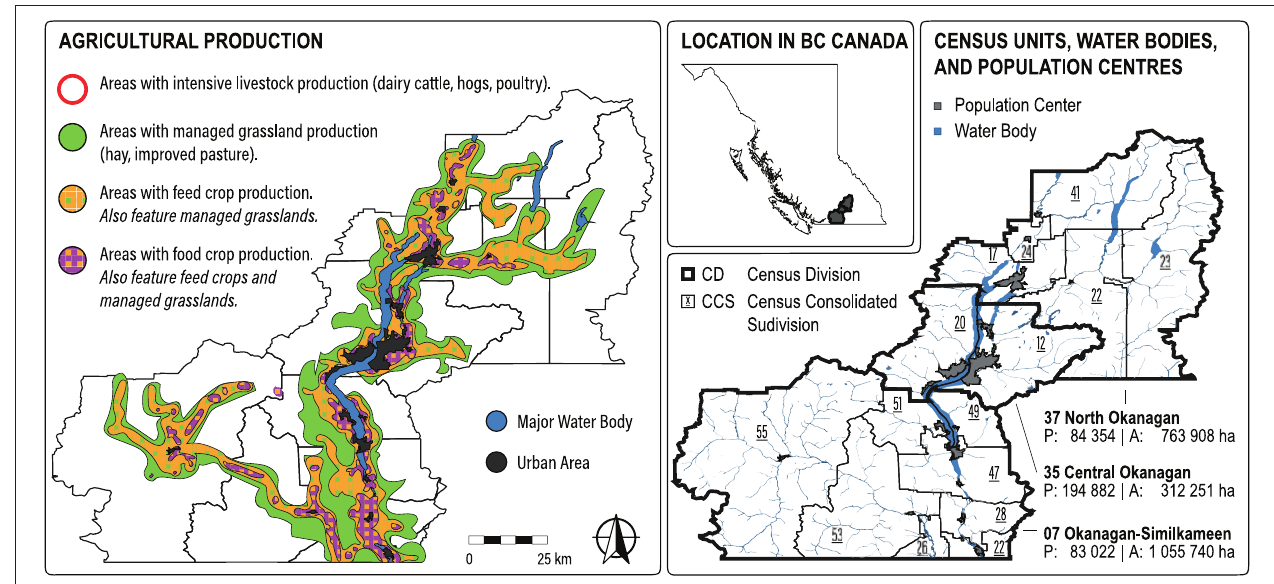
FIGURE 1 | Overview of the Okanagan bioregion. The Okanagan population is largely centered in the bioregion along the Okanagan Lake. Crop production takes place mainly on and near valley bottoms, with feed crops and managed grassland extending progressively further away. Intensive livestock production is concentrated in two areas in the north of the bioregion and coincides with areas of intensive feed production. Grazing on rangeland and natural pastures is commonplace in the foothill areas toward the periphery in the northeast and southwest of the bioregion. P = population and A = area. Figure adapted from Harder et al.